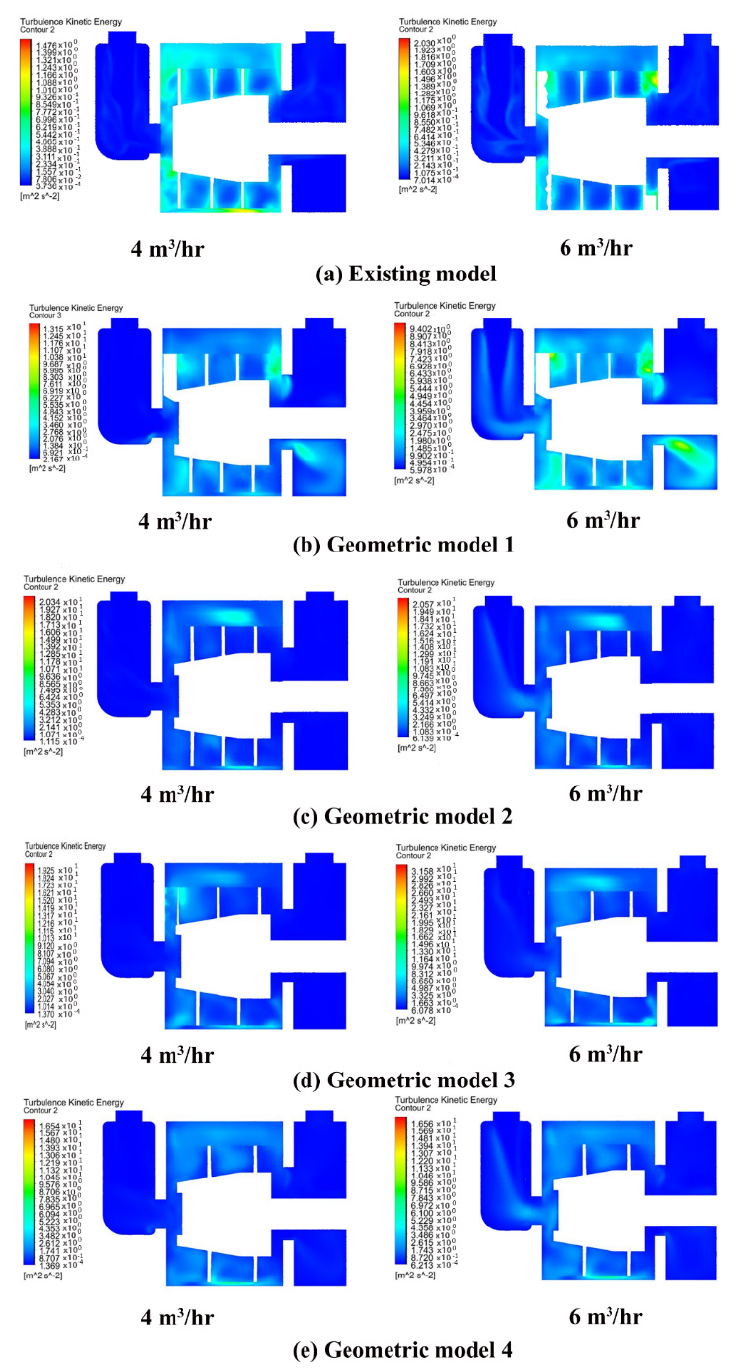
Figure 18. Variation of turbulent kinetic energy in different geometric models ( a ) Existing model ( b ) Geometric model 1 ( c ) Geometric model 2 ( d ) Geometric model 3 and ( e ) Geometric model 4.